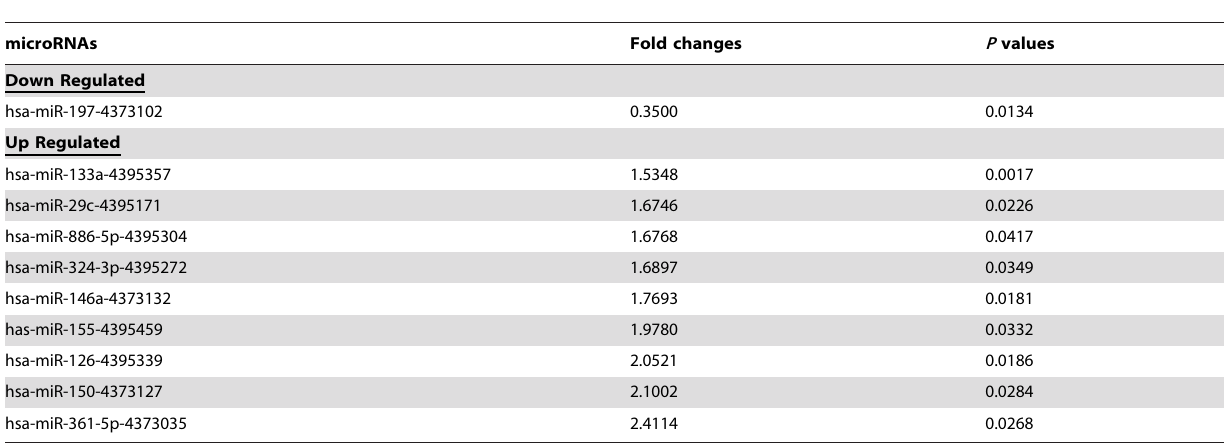
Table 1. Differential expression of microRNAs in MDMs infected with F. tularensis LVS.